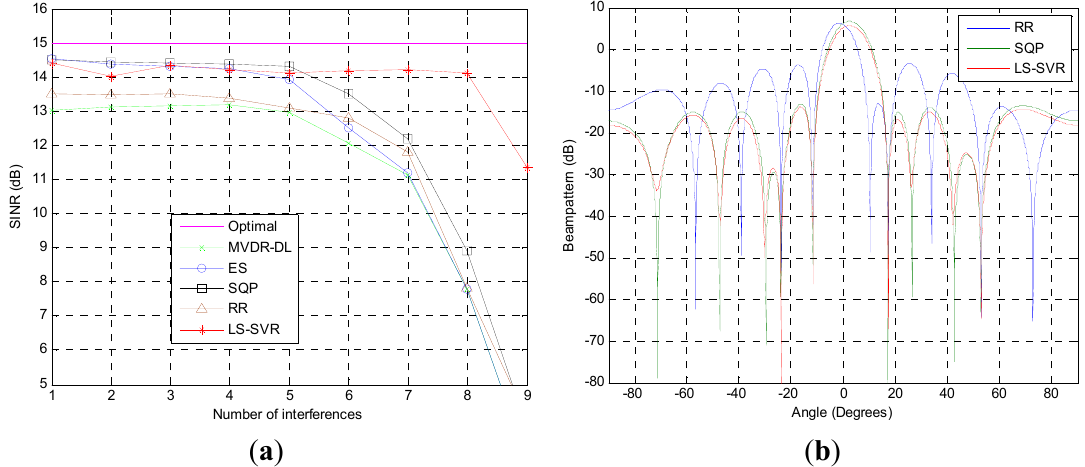
Figure 3. Scenario with DOA mismatch and multiple interferences ( a ) SINR versus Number of interferences; ( b ) Beam-patterns, SNR = 10 dB, 4